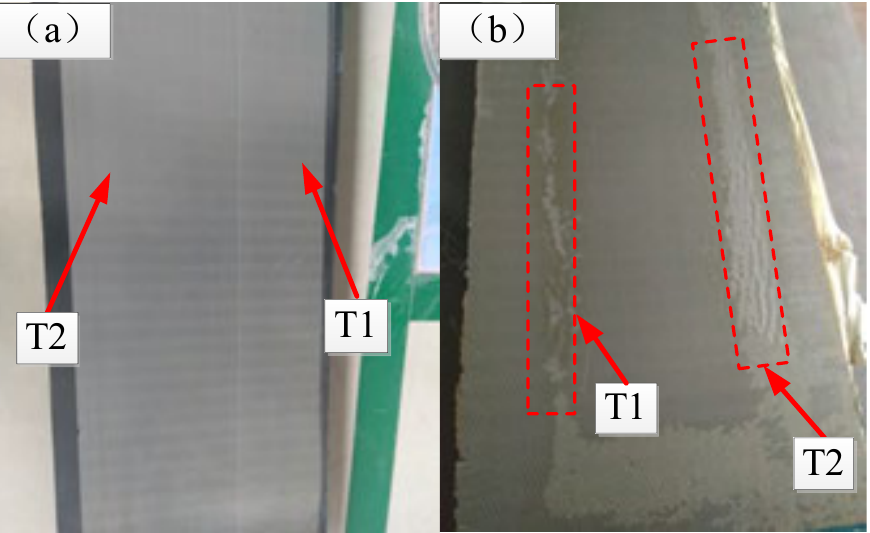
Figure 12. Experimental results of lower panel skin in different cases. ( a ) Case 1; ( b ) Case 2.